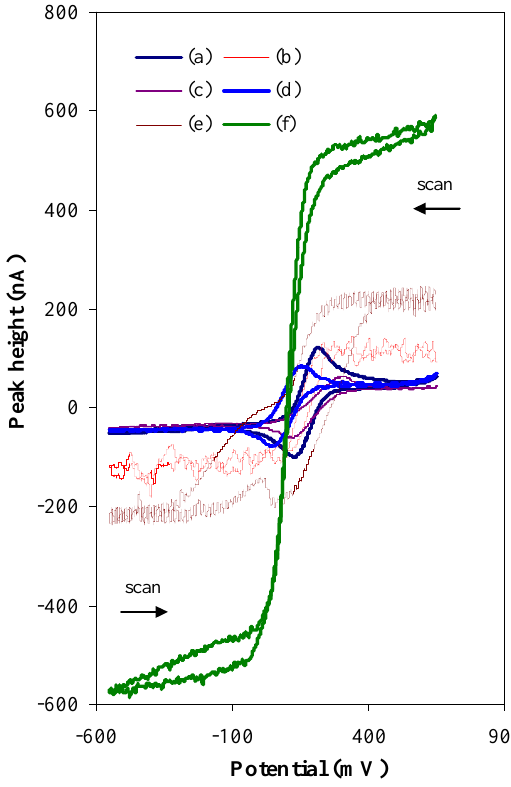
Figure 4. Cyclic voltammograms of 0.1 M potassium ferrocyanide-ferricyanide measured by TFT sensor with gold working electrode at different arrangements of electrochemical analysis in combination with flow of background electrolyte: ( a ) non stirred arrangement; ( b ) continual stirred arrangement; ( c ) application peristaltic pump at flow of 0.4 ml/min; ( d ) microperistaltic pump at flow of 100 µl/min; ( e ) micro-flow system at flow of 10 µl/min; ( f ) rotating vessel at 175 rpm. Background electrolyte 0.1 M KCl. CV parameters were as follows: the initial potential of -550 mV, the